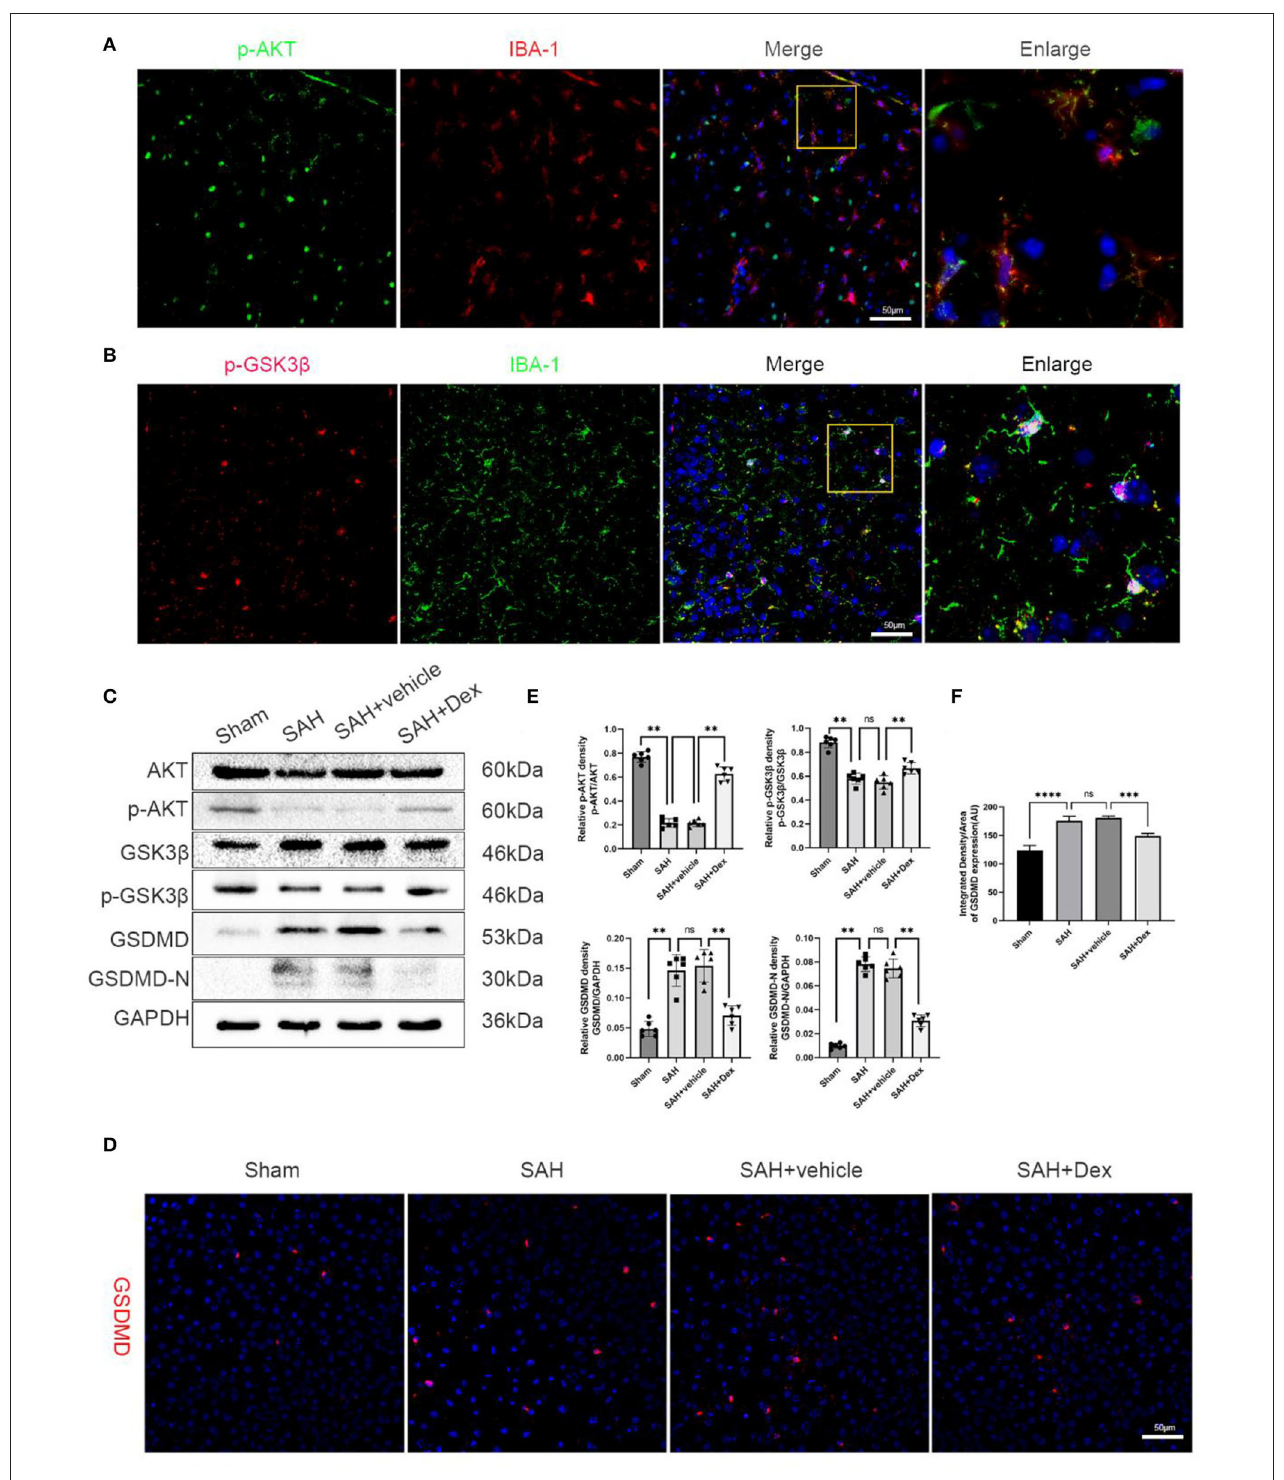
FIGURE 6 | Effects of Dex treatment on PI3K/AKT/GSK3 β pathway, protein levels of GSDMD and GSDMD-N. (A) Representative images of co-immunofluorescence staining of p-AKT (green) and microglia (IBA1, red) in the ipsilateral cortex at 24h after SAH. Scale bars = 50 µ m. (B) Representative images of co-immunofluorescence staining of p-GSK3 β (red) and microglia (IBA1, green) in the ipsilateral cortex at 24h after SAH. Scale bars = 50 µ m. (C) Representative Western blot images. (D) Representative images of immunofluorescence staining GSDMD. Scale bar = 50 µ m. (E,F) Quantitative analysis of western blot and immunofluorescence staining. n = 6 in each group. Data are expressed as mean ± SD. ** p < 0.01, *** p < 0.001, **** p < 0.0001.